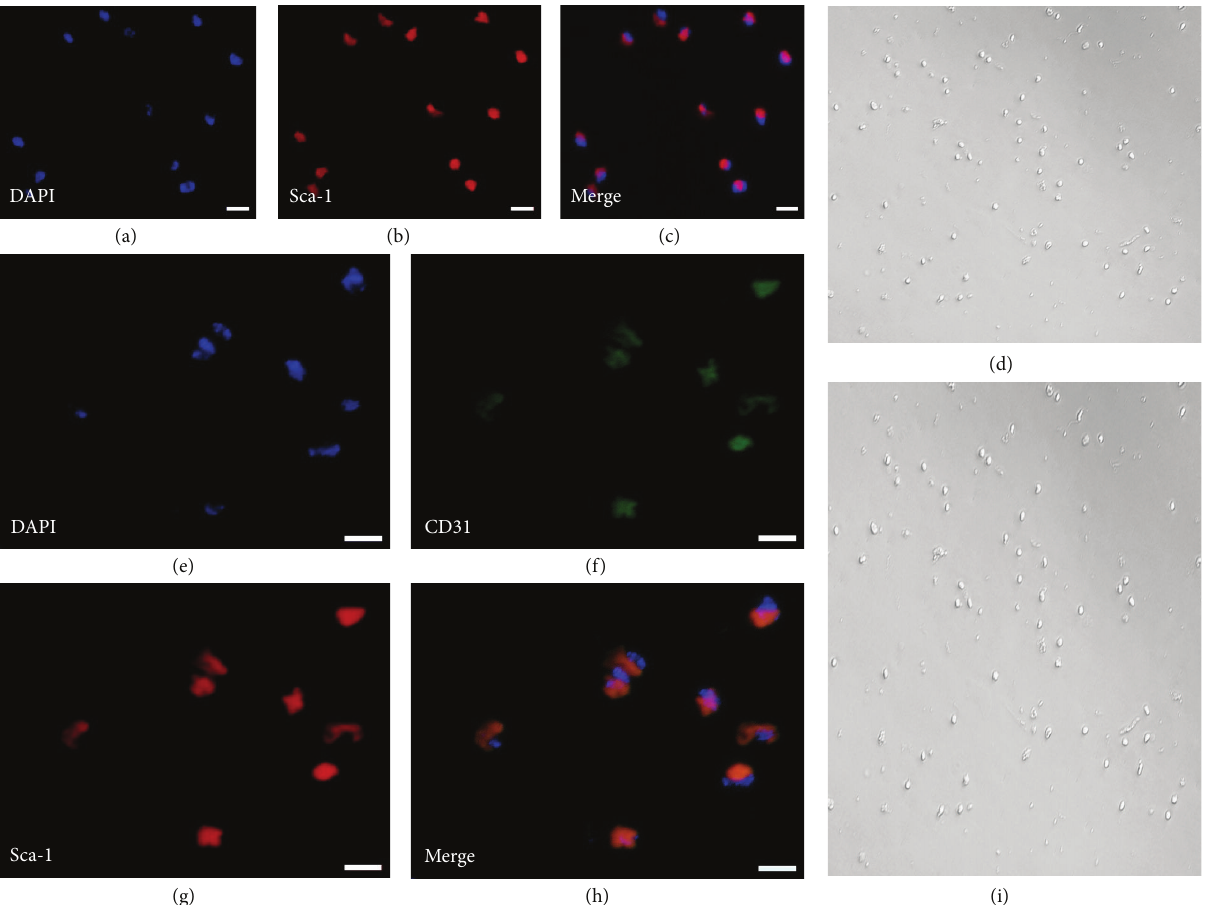
Figure 1: Analysis of CD31 and Sca-1 expression by IF staining. (a–c) Sca-1 expression in Sca-1 + CD31 − cells with Sca-1 only in Sca-1 + CD31 −